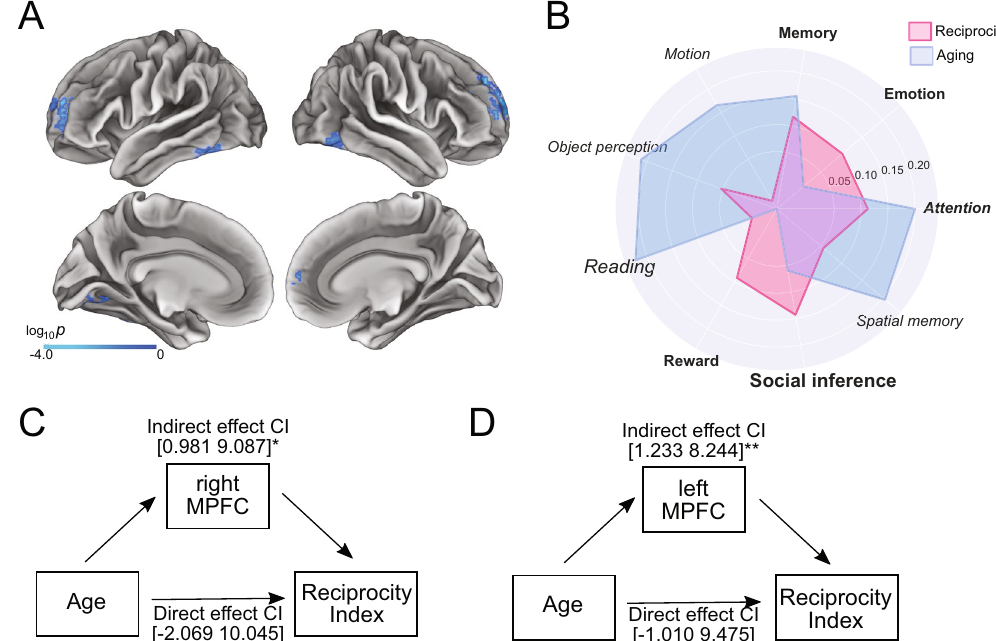
Figure 3. Brain structure results. ( A ) Cortical thickness correlated with reciprocity index. ( B ) Decoding with Neurosynth of the regions associated with reciprocity index (pink) and the regions associated with age (blue). The top 5 topics from the reciprocity map (boldface) and the aging map (italic) are shown in the polar map. The topics that showed the highest correlation in each analysis are marked with larger font. Social inference was the topic that showed the highest correlation with the association between the reciprocity index and the cortical thickness. ( C ) ( D ) Mediation analysis showing the significant indirect effect of age on reciprocity index through the cortical thickness of right and left MPFC. The relationship between age and the fairness consideration were mediated by the developmental changes of cortical thickness of the MPFC, after controlling for the effect of sex and IQ. Solid line and dashed line indicate significant and non-significant pathways, respectively. Indirect effect and direct effect CIs are the 95% confidence intervals of the coefficients obtained from non- parametric bootstrap methods. Brain figure created using Connectome Workbench software (http://www. humanconnectome.org/software/connectome-workbench.html). * p < 0.05. ** p <